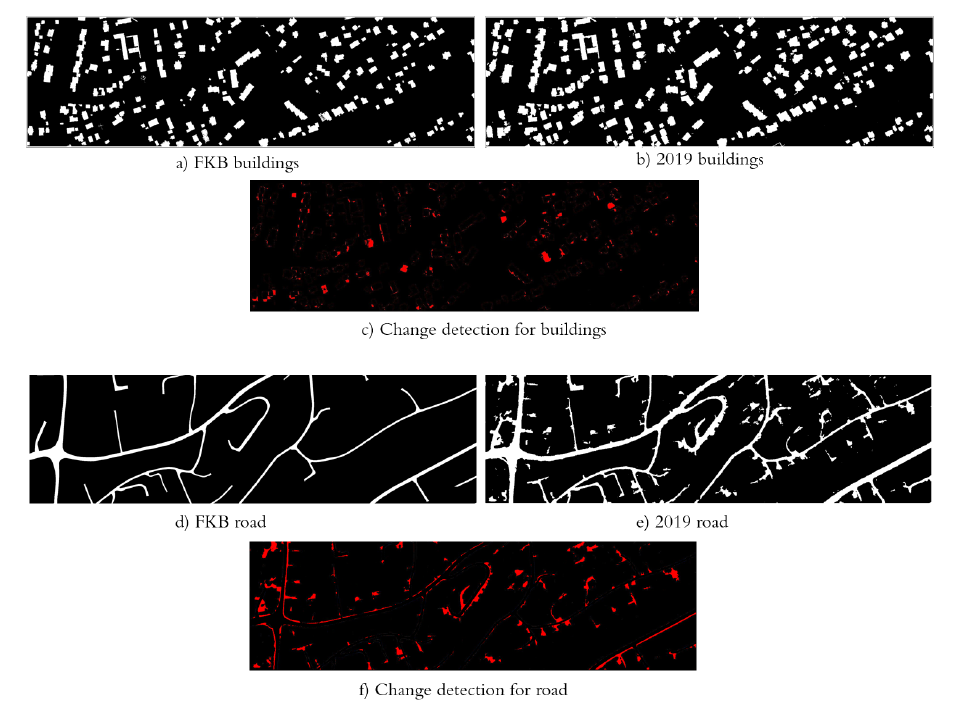
Figure 10. Change detection results for buildings and roads from FKB reference data to 2019 representing ( a ) buildings from the reference image (FKB), and ( b ) from 2019, ( c ) change detection for buildings, ( d ) roads from the FKB, and ( e ) from 2019, and ( f ) change detection for roads. Red color highlights changed pixels in the updated map. Figure 11 depicts the change detection results from 2019 to 2021 for roads, low and high vegetation.